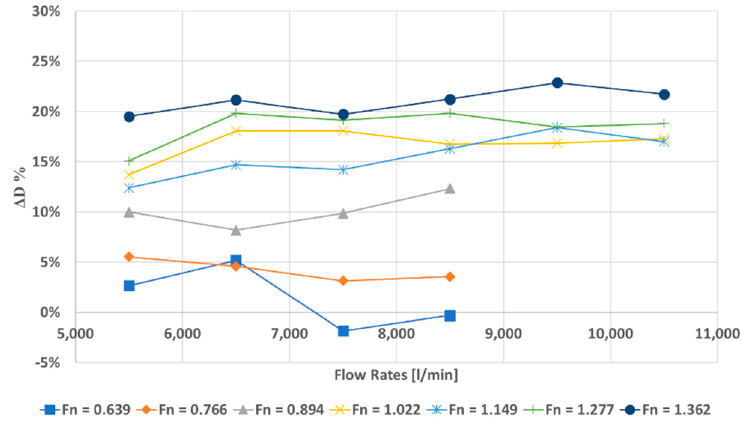
Figure 19. Wetted surface comparison–Air (9500 L/min and 10,500 L/min) and No air.